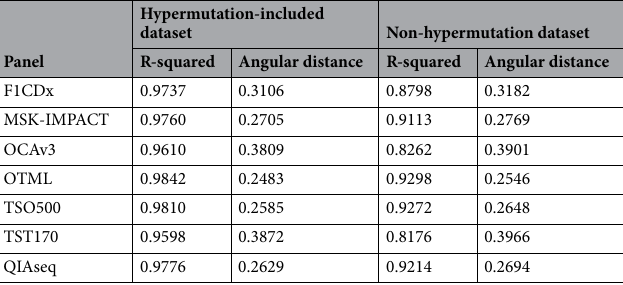
Table 1. The R-squared values and average angular distances for the selected panels.